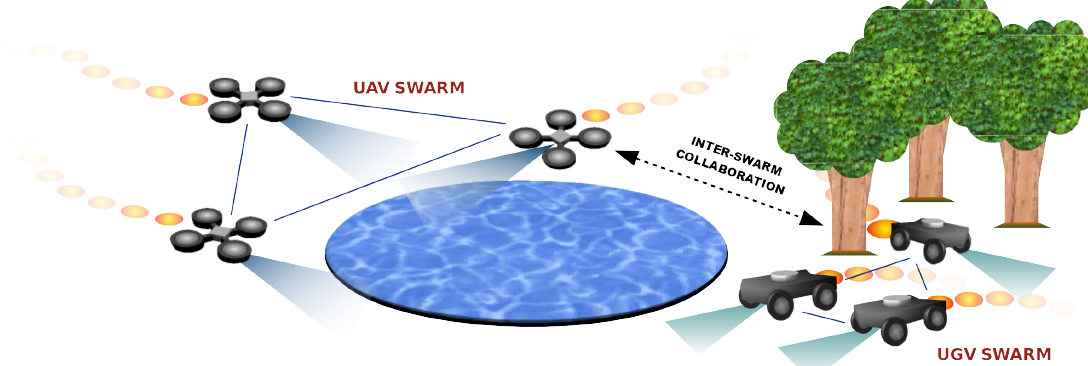
Figure 1. Attractor Based Inter-Swarm collaborationS (ABISS). In this example, a UAV swarm explores a water surface that UGVs cannot